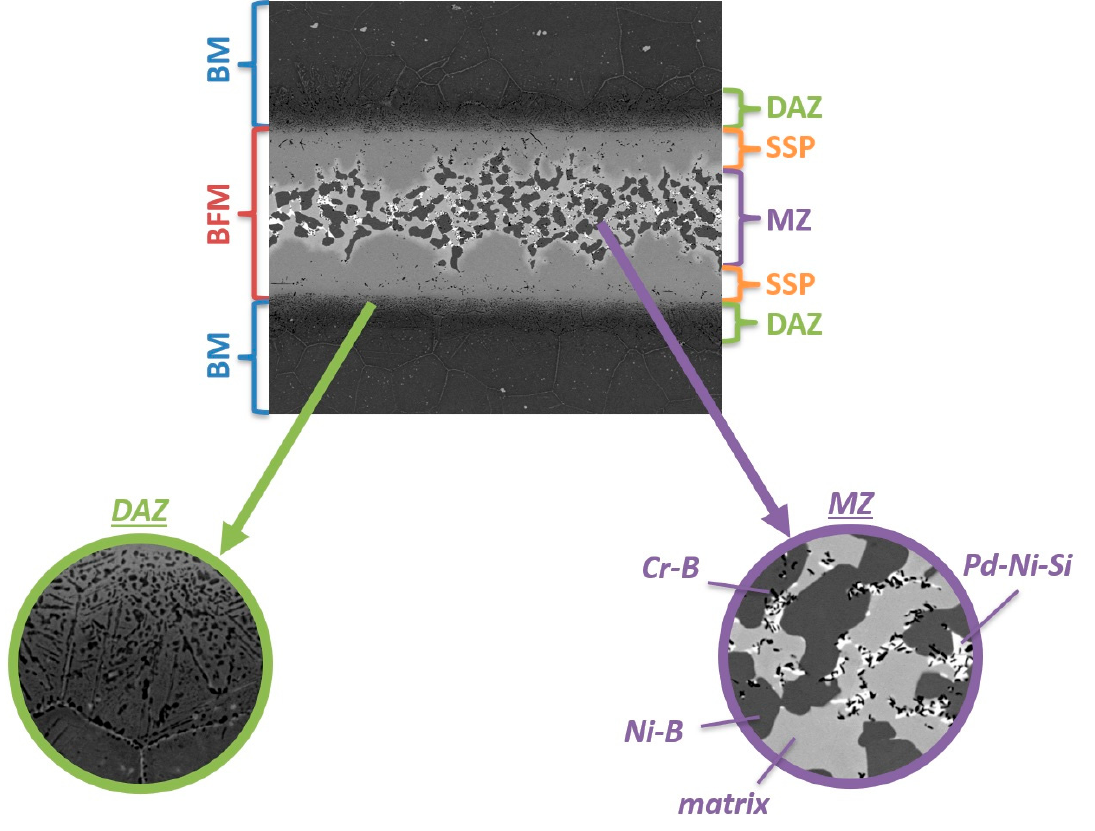
Figure 9. Summarized structure of Hastelloy X–Palnicro 36M brazed joint designed for mechanical testing.